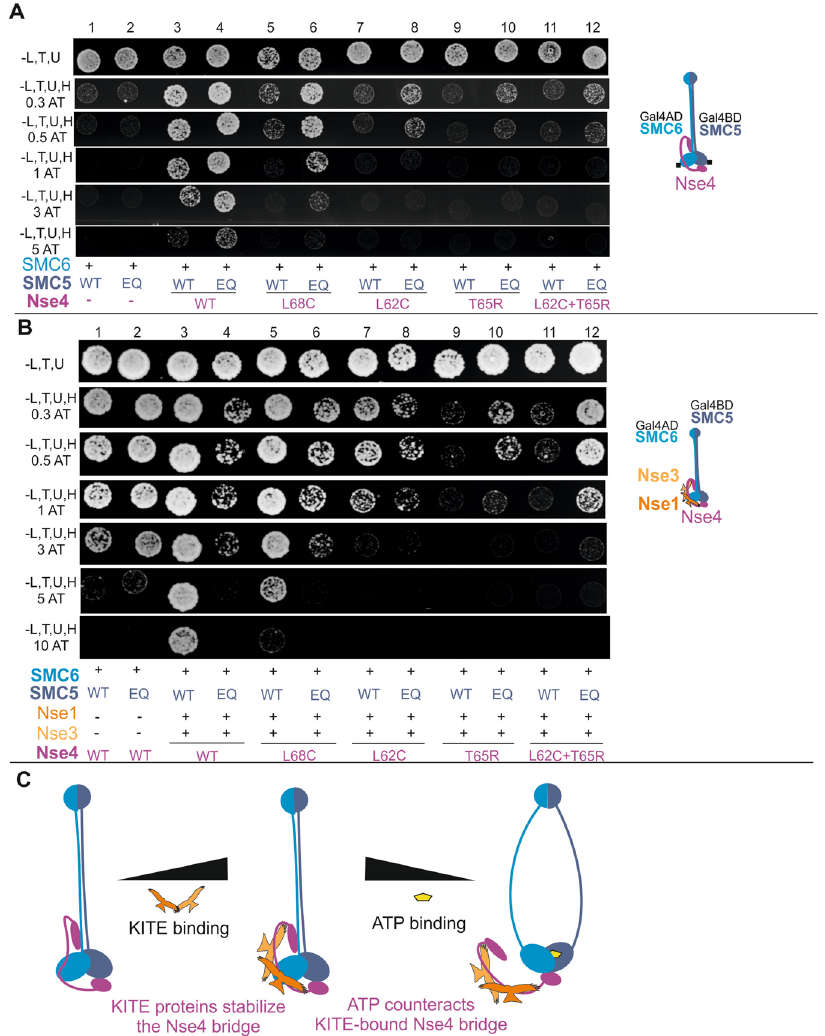
Figure 3. A role of Nse4 and ATP molecules in bridging of SMC5-SMC6. ( A ) Nse4 is essential for the bridging of the hybrid SMC5-SMC6 constructs (columns 1–4). The SMC5/E995 conserved residue was mutated to glutamine (EQ) to inhibit ATP hydrolysis. The ATP retention has only mild additive effect on the stability of the SMC5-Nse4-SMC6 complex (scored on plates containing increasing concentrations of 3-Amino-1,2,4- triazole). The Nse4 mutations affect the stability of the wild-type SMC5 complexes more dramatically than the stability of the SMC5/E995Q mutant complexes (compare odd and even columns). Wild-type (WT) or E995Q (EQ) mutant versions of SMC5 are labelled in grey below the panels (further details as in Figs. 1 and 2). ( B ) Addition of the Nse1 and Nse3 KITE proteins to the above SMC5/SMC6/Nse4 system stabilizes the SMC5- Nse4-SMC6 bridge. Although the KITE proteins stabilize the ATP-free SMC5-Nse4-SMC6 complex (columns 1 and 3), they destabilize the ATP-bound complex (columns 2 and 4). The Nse4 mutations decrease stability of the ATP-free SMC5-SMC6-Nse4-Nse3-Nse1 complex gradually (columns 5, 7, 9 and 11), while the stability of the ATP-bound complexes drops first (columns 6, 8, and 10) and then it recovers in the L62C, T65R double mutant (column 12). ( C ) Schematic summary of the panel A and B results showing the stabilizing effect of the KITE binding to the Nse4 bridge and the destabilizing effect of ATP to the KITE-bound Nse4 bridge. The ATP- imposed constraint is partially released via dissociation of the Nse4-SMC6